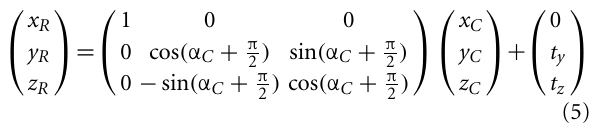
FIGURE 3 | The coordinate systems used along the scanning direction. y R , z R are the real world coordinates, y C , z C the ones of the camera. x L is the distance of the laser line plane perpendicular to n L from the camera origin. α C is the inclination angle of the sensor with respect to the horizontal plane and α L the laser inclination angle with respect to the camera.